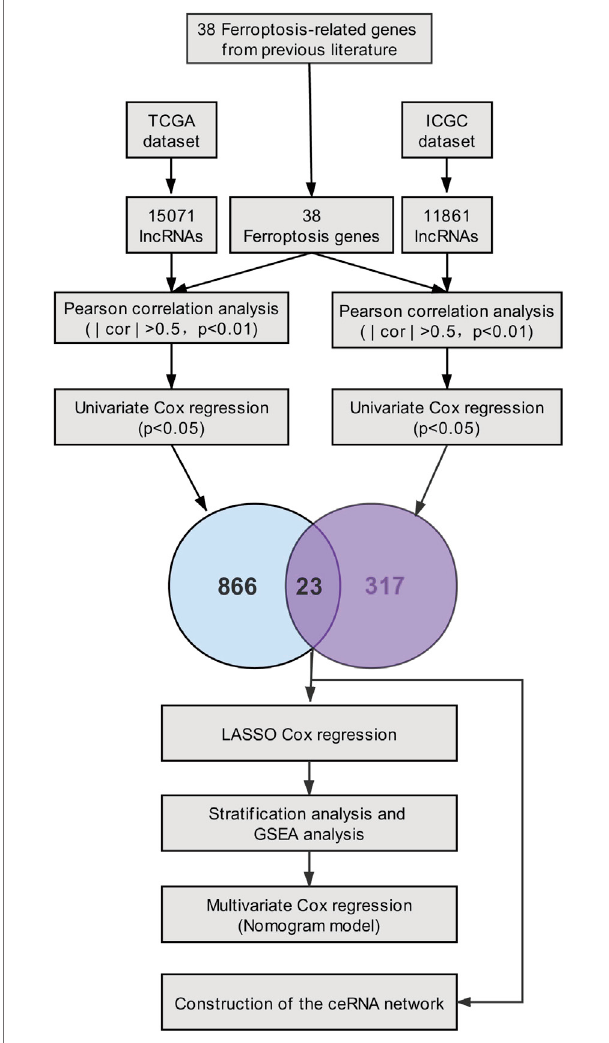
FIGURE 1 | Flow diagram of the